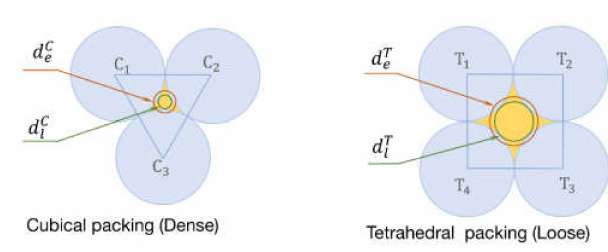
Figure 4. Calculation of the transferred coe ffi cient from the equivalent area diameter to the largest diameter that fits into the